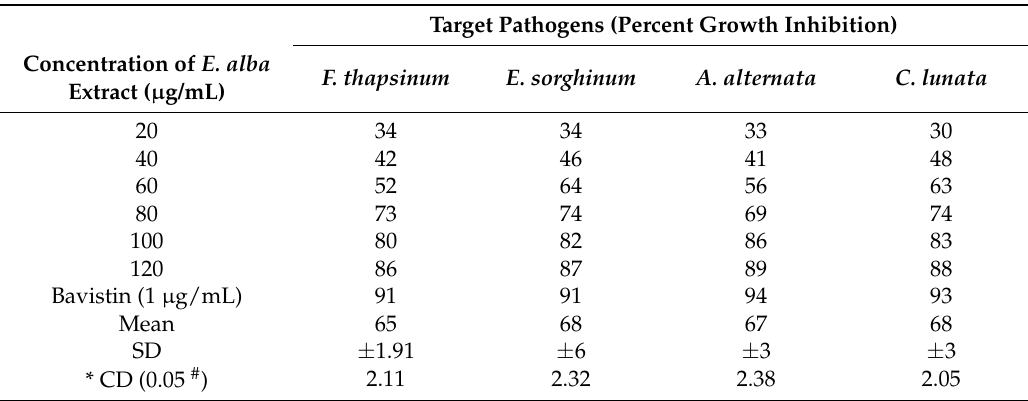
Table 3. Influence of purified E. alba methanol extract on sorghum pathogens and growth parameters under greenhouse condition.